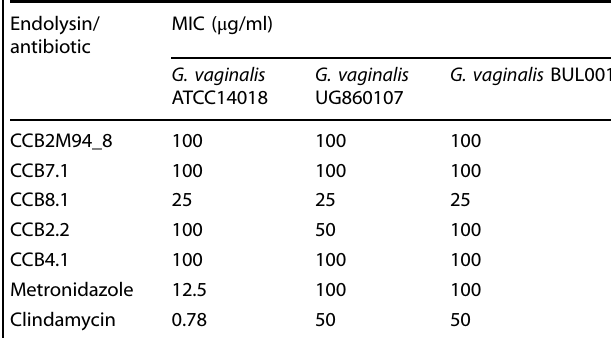
Table 3. MIC for fi ve different endolysin candidates, metronidazole, and clindamycin against three different G. vaginalis